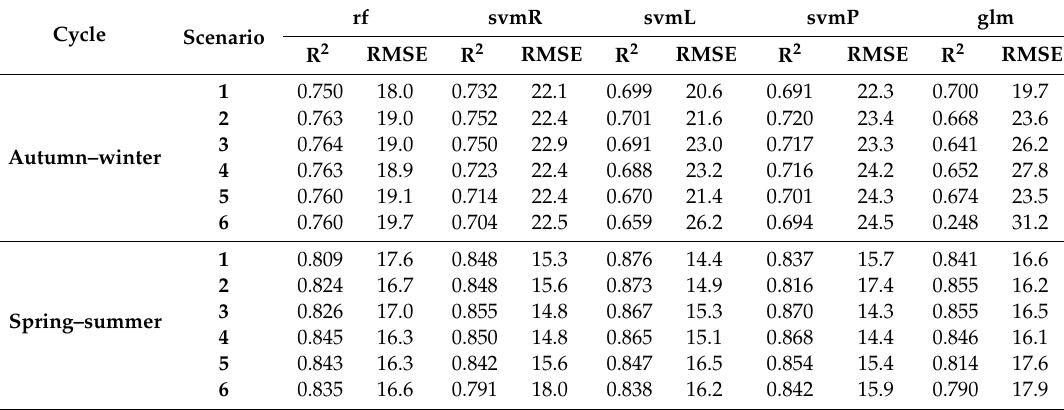
Table 2. Model performance per algorithm, cycle, and months used to create variables from the harvest date. The test dataset corresponds to the independent hold-out set (2017 and 2018). Cycle